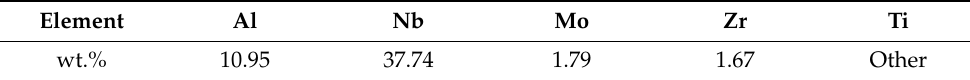
Table 1. Major contents of Ti 2 AlNb.